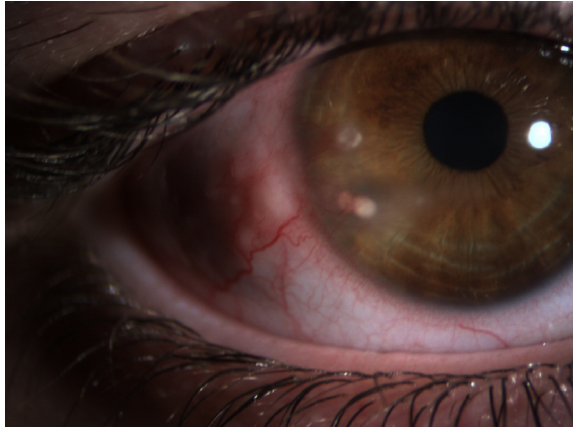
Figure 1: Slit-lamp photograph at presentation reveals in the right eye conjunctival hyperemia and bulbar phlyctenae, infiltrates of peripheral temporal cornea at eight and nine clock hours with corneal neovascularization.